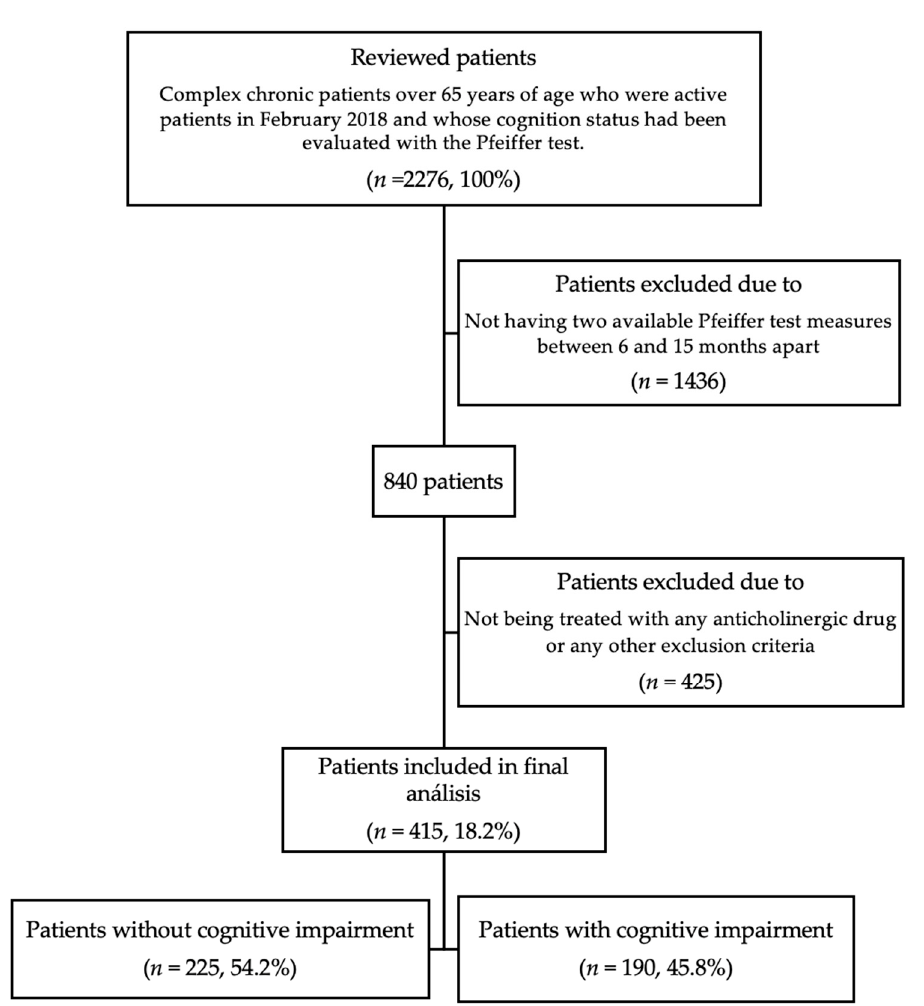
Figure 1. Flow diagram of patients selection process and analysis.